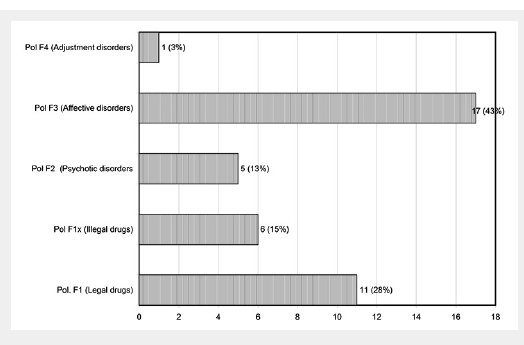
Psychiatric diagnoses and relevant information on suicides with psychiatric files (n = 81).